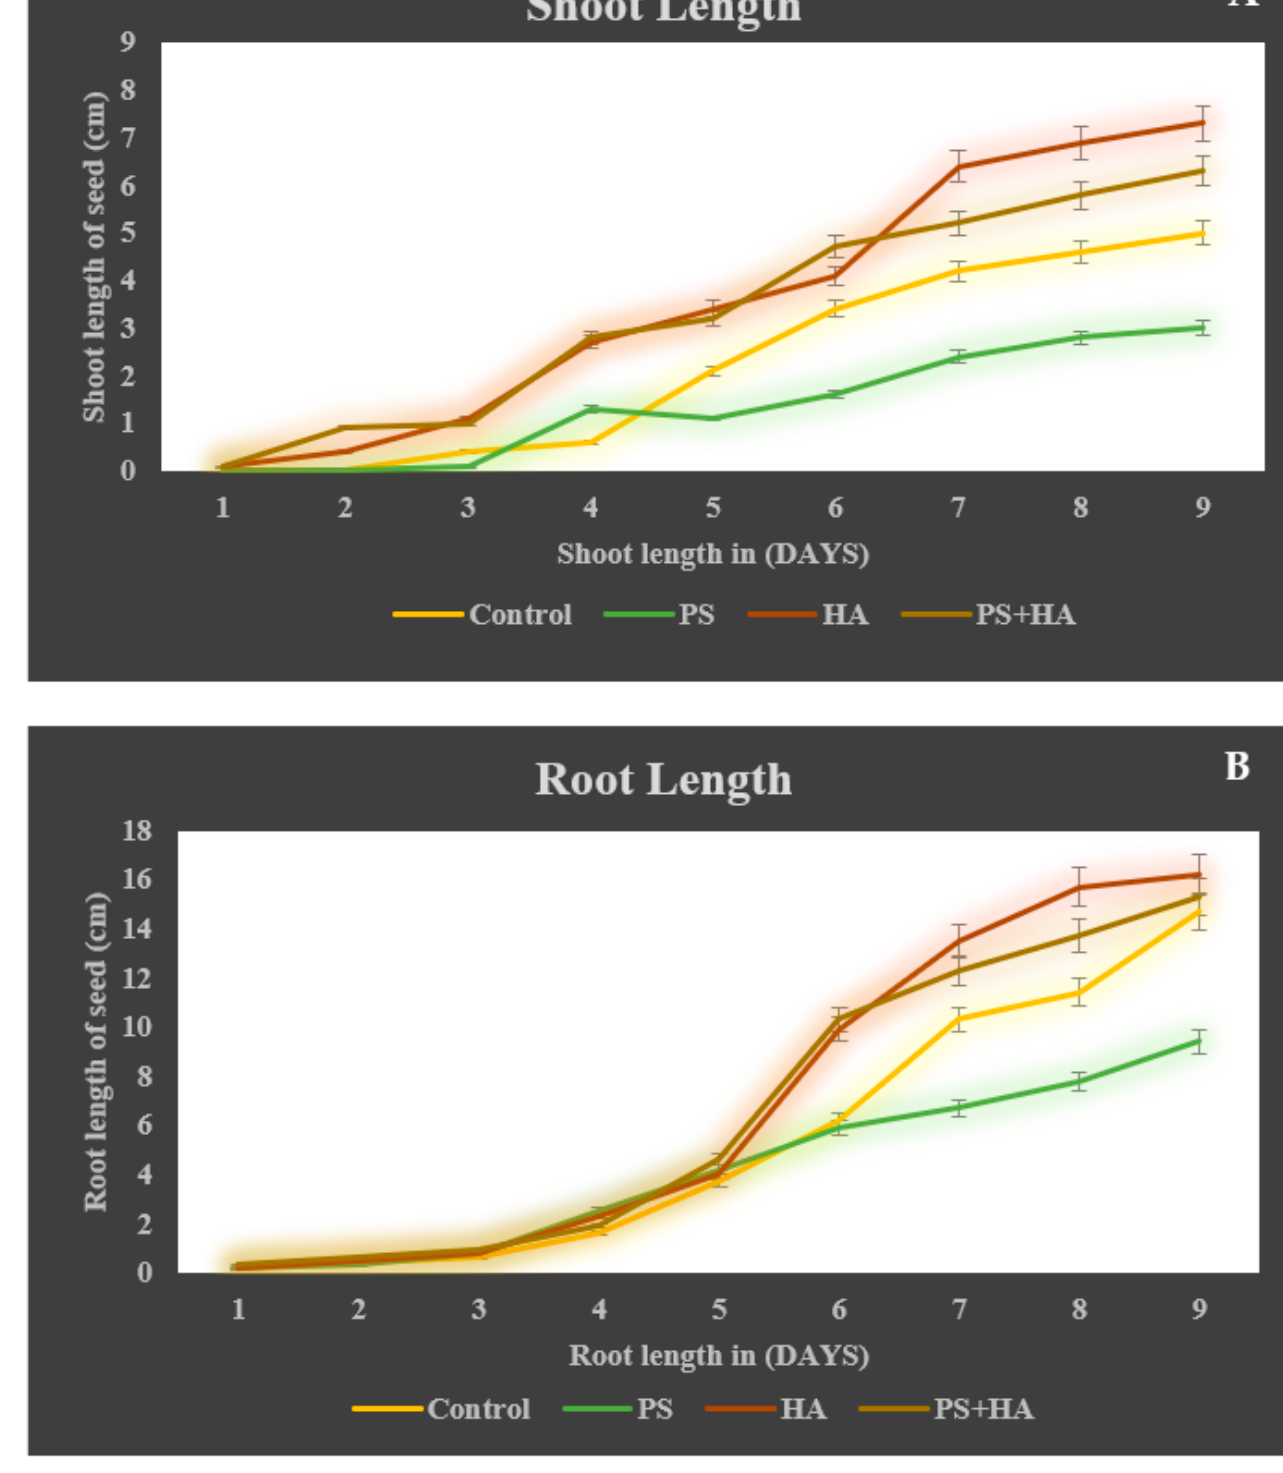
Figure 6. This line graph shows the Shoot length ( A ) and Root length ( B ) in PS, HA, and PS + HA.